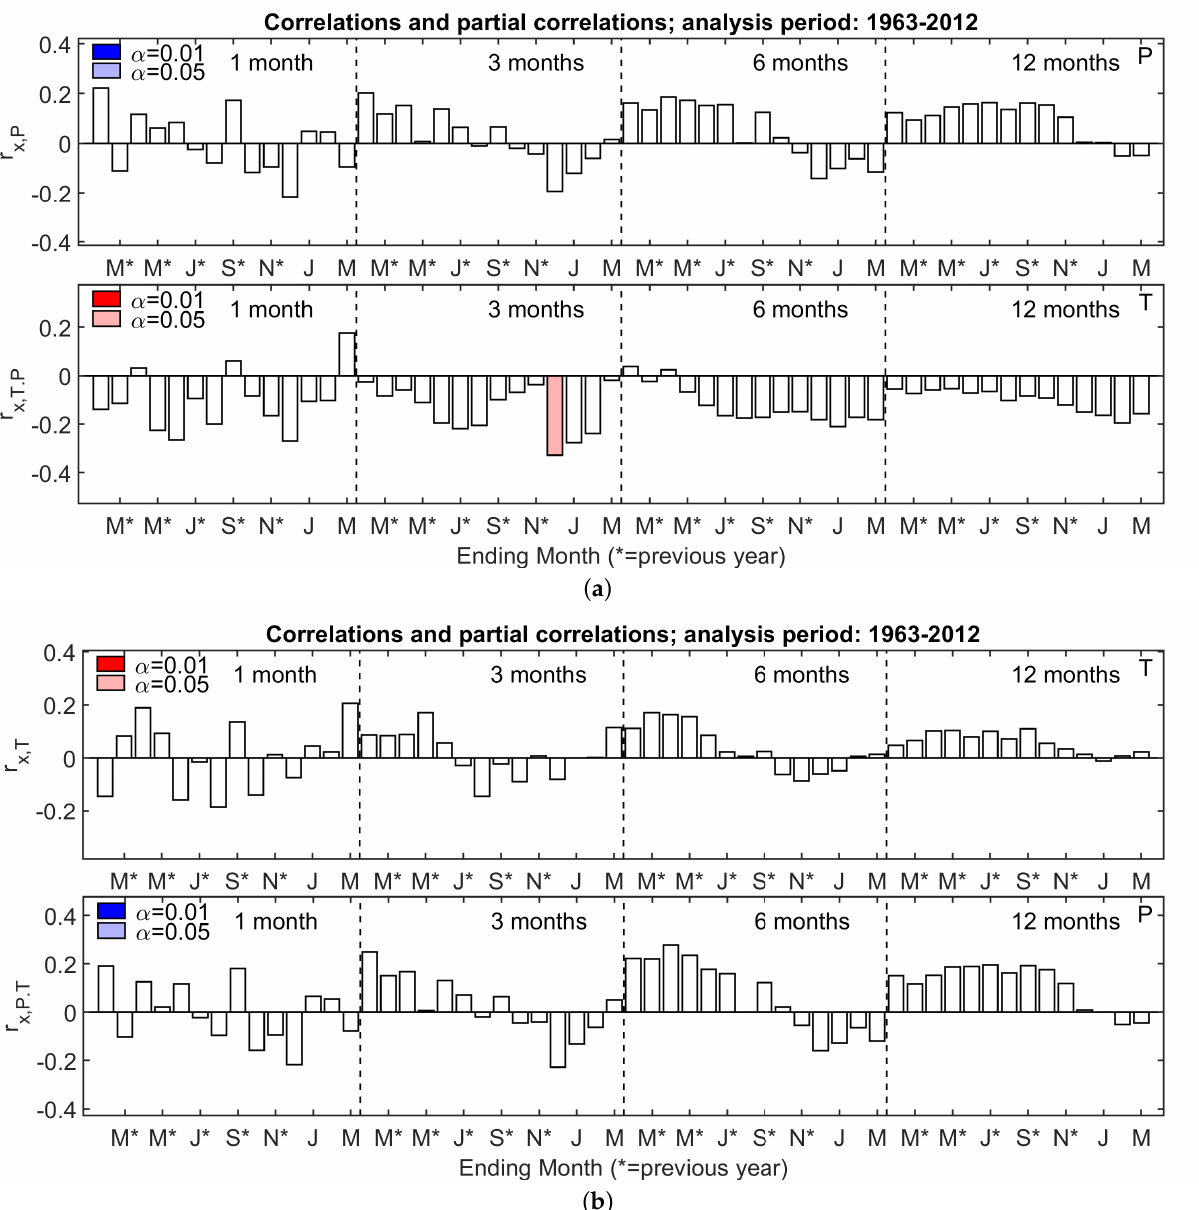
Figure 7. Correlations ( top panel ) and partial correlations ( bottom panel ) of mean chronology with the precipitation (P) and temperature (T). In each top panel are the simple correlations with the primary climate variable, and in each bottom panel, the partial correlations of mean chronology with the secondary climate variable. Significance at α = 0.05 and α = 0.01 color-coded. Notation r x , P ( r x , t ) means correlation of x (mean chronology) with P ( T ); r x , T . P ( r x , P . T ) means partial correlation of x with T ( P ) , controlling for influence of P ( T ). ( a ) Top —Precipitation simple correlation. Bottom —Temperature partial correlation. ( b ) Top —Temperature simple correlation. Bottom —Precipitation partial